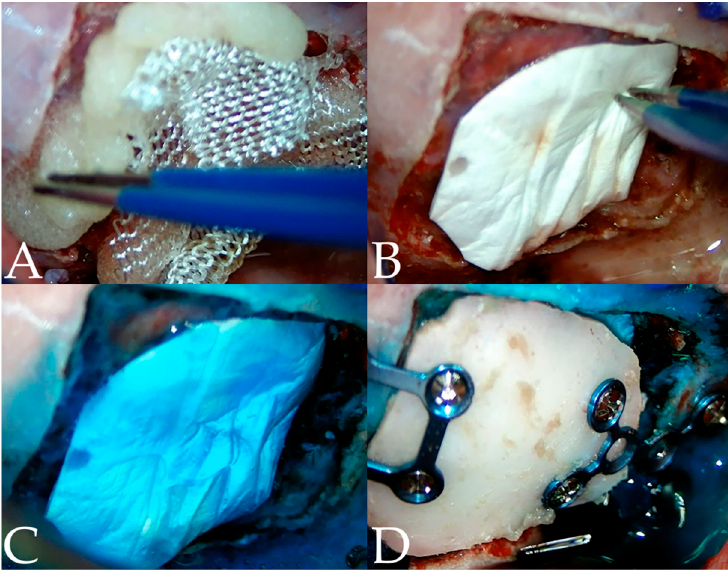
Figure 6. When minor hemorrhage occurred after the resection, Floseal and Surgicel ( A ) were used at the surgical site. ( B ) Once the bleeding stopped, artificial dura was used to cover the defect of the meninges. ( C ) The dural sealant was used over the artificial dura to prevent the leakage of CSF. ( D ) The osteotomy block was placed on the defect and fixed with a neurosurgical plate.